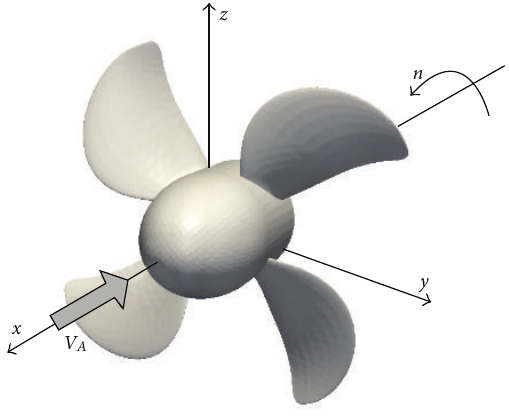
Figure 4: Geometry of investigated propeller.